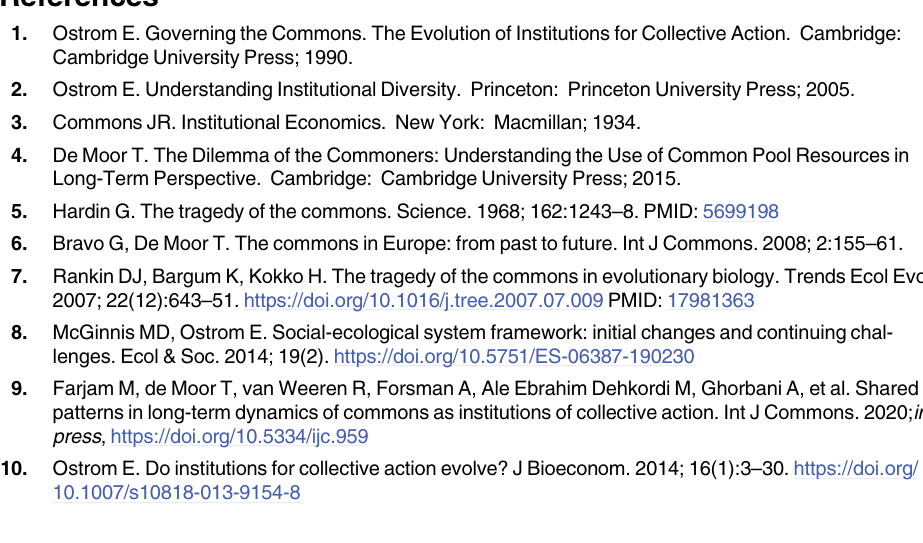
commons between the 8th and the middle of the 19th